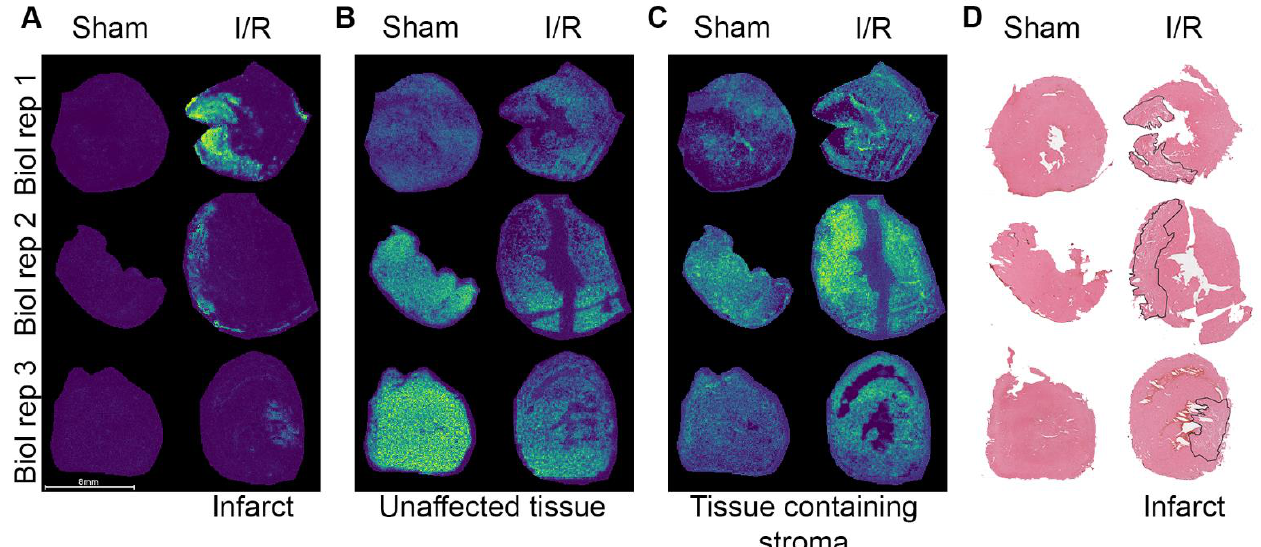
Figure 2. PLSA analysis revealed distinct regions within the I/R heart. These regions were identified as infarct ( A ), unaffected tissue ( B ) and tissue containing interstitial stroma ( C ). The infarct region is annotated in H&E-stained consecutive sections and represented in black ( D , detailed annotations are depicted in Figure S4). Biol rep = biological replicate.